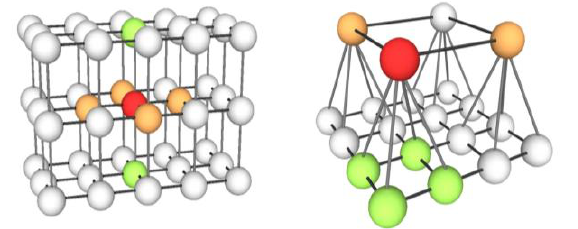
Figure 1. Multitemporal graph structure. Left: images having the same resolution. Right: images having different resolutions. Red nodes: processed primitives; orange / green nodes: spatial / temporal